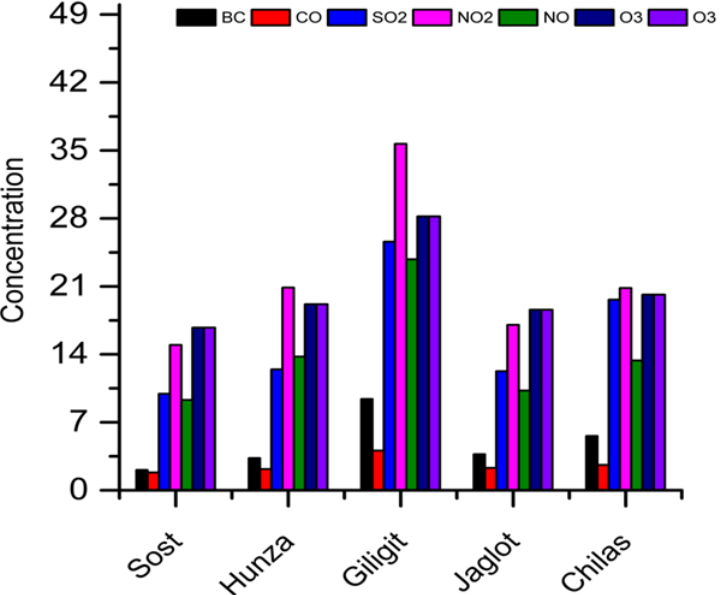
Figure 4. Daily average air quality indicators at all study sites during winter, 2019.